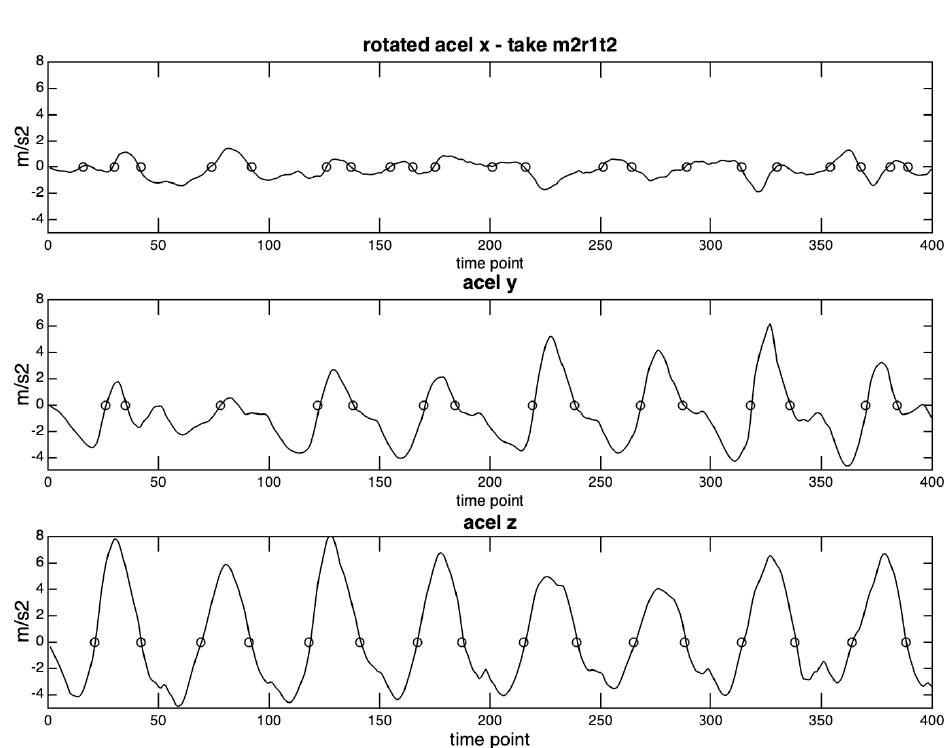
Figure 15. 3D acceleration curves and zero-crossings from take m2r1t2.